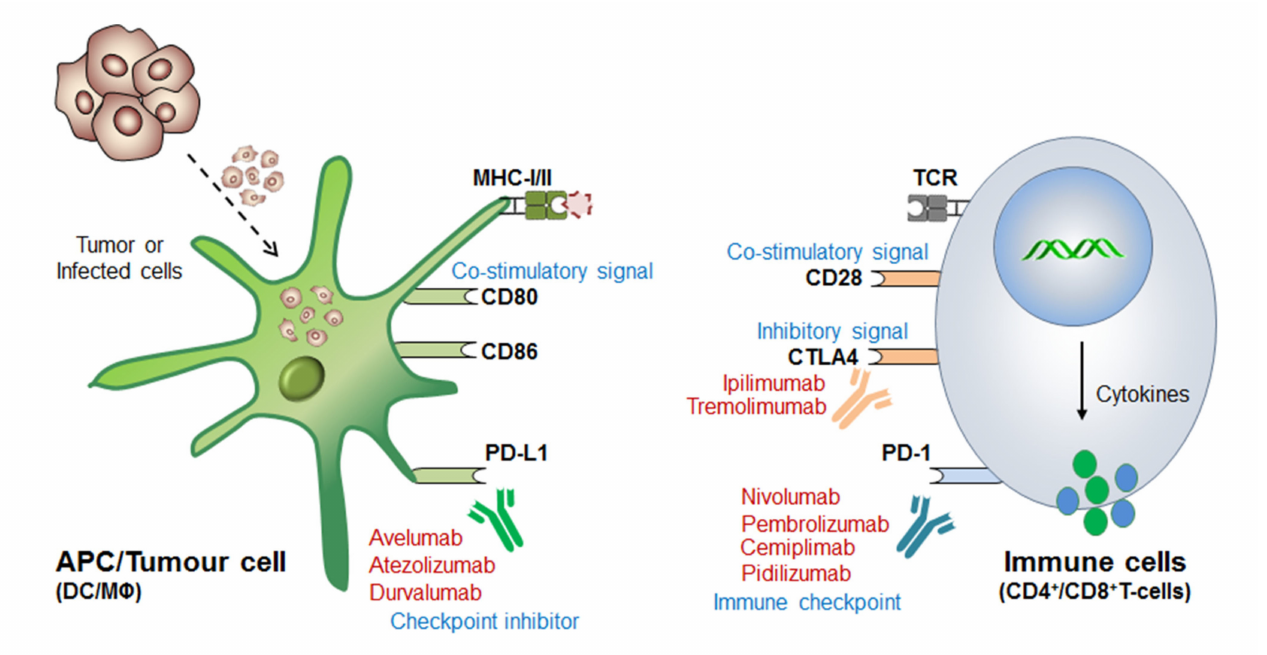
Figure 2. Mechanism of immune checkpoint blockage or inhibition (ICB/ICI) therapy. The antigen presenting cells (APCs), especially dendritic cells and macrophages recognize and engulf the virus-infected or cancerous cells. The immune cells now processed and present the antigen to the naive T-cells in conjugation with MHC-I/II. The T-cell receptor (TCR) present on the immune cells recognizes this processed antigen and activates humoral as well as cell-mediated immune response. However, interestingly, immune cells, like CD8 + T-cells also express PD-1 marker which function as “immune checkpoint” before cytolytic activation. On the other hand, tumor-engulfed DCs also expresses PD-L1 and PD-L2 (ligand for PD-1) and inhibitor bypass the function of immune activation called “immune checkpoint inhibitor” and thus T-cells filed to recognize it and considered as ‘self’ rather than ‘foreign’. Therefore tumor cell escapes this immune-surveillance mechanism and proliferates rapidly. Blocking these immune checkpoint markers by means of specific antibodies endorsed the discovery of ICB-therapeutics, for example, (i) Anti-PD-1 therapy (or Immune cell targeted therapy): Nivolumab (Opdivo®), Pembrolizumab (Keytruda®), Pedilizumab (CT-011) and Cemiplimab (Libtayo®) block PD-1 receptor